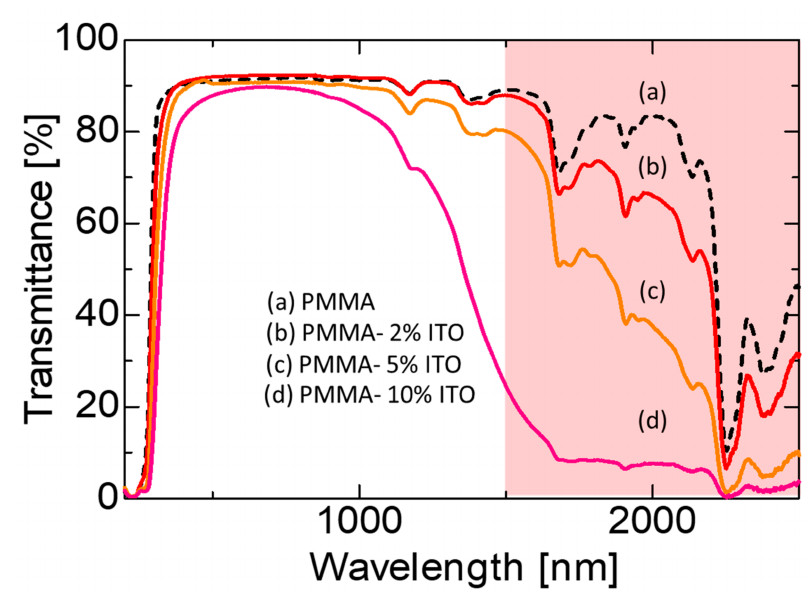
Figure 6. Transmittance properties of the PMMA-ITO composite pellet obtained using ITO nanoparticles modified using pH